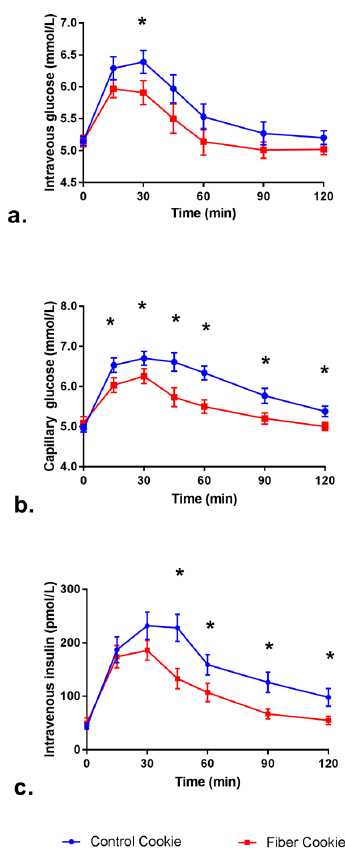
Figure 2. Post-prandial blood measurements over 120 min ( a ) intravenous blood glucose; ( b ) capillary blood glucose; ( c ) intravenous insulin concentrations. Data are presented as means ± SEM. * = Fiber cookie and control cookie were significantly different ( p < 0.05). Table 4. Sensory ratings of the fiber cookie and control